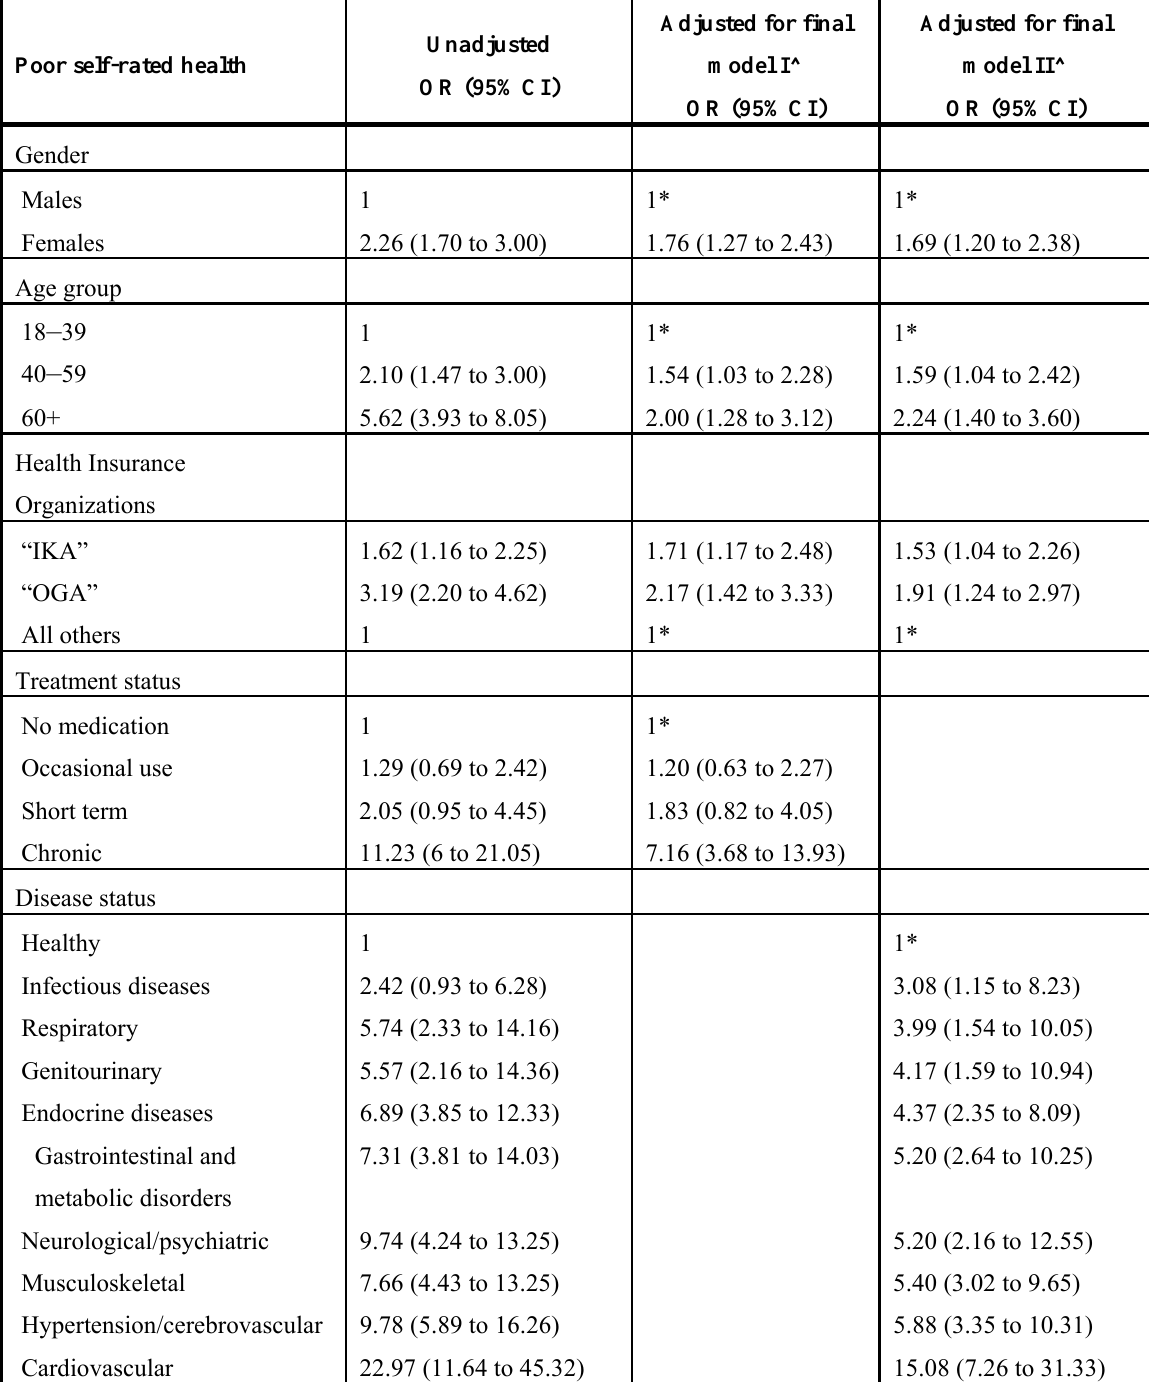
Table 3. Logistic Regression of Poor Health on Selected Determinants of